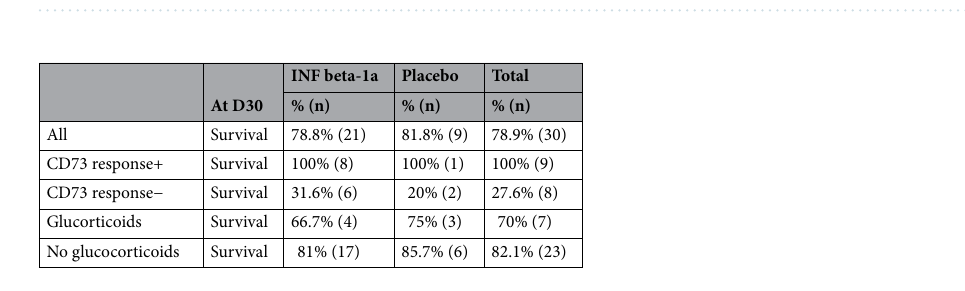
Table 1. Baseline demographics and procedural characteristics. COPD chronic obstructive pulmonary disease, RBC red blood cell.